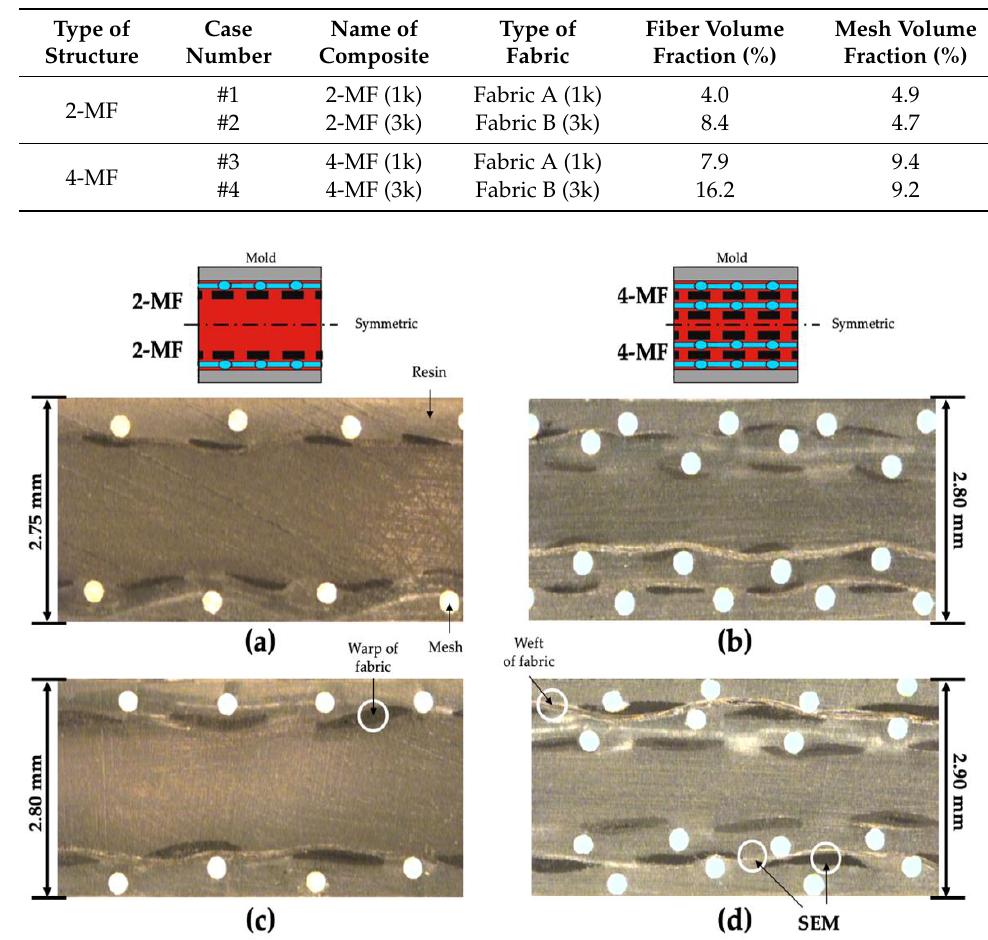
Table 5. Compositions of mesh-inserted composites.